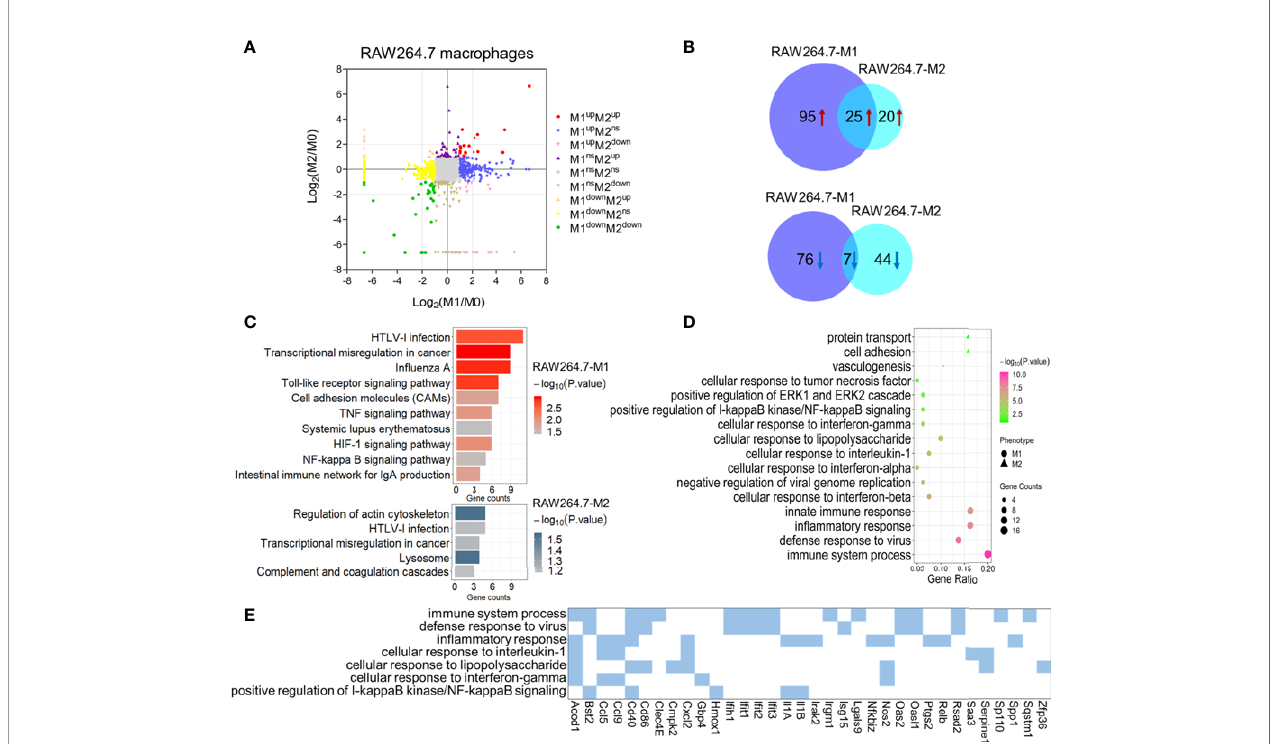
FIGURE 3 | Identi fi cation and bioinformatic analysis of differentially expressed proteins from M1 and M2 types of polarized mouse RAW264.7 macrophages. (A) Scatter plot showing the distribution of differentially expressed proteins in M1 and M2 polarized macrophages, compared to the M0 macrophages. (B) Venn diagram of differentially expressed proteins between two types of polarized macrophages. Upper: up-regulated; lower: down-regulated. (C) KEGG pathway analysis of differentially expressed proteins in M1 (upper) and M2 (lower) macrophages from mouse RAW264.7 cells. (D) Gene ontology enrichment analysis (biological process) of up-regulated proteins in M1 and/or M2 phenotypes. (E) The enriched biological processes corresponding to the up-regulated proteins in M1